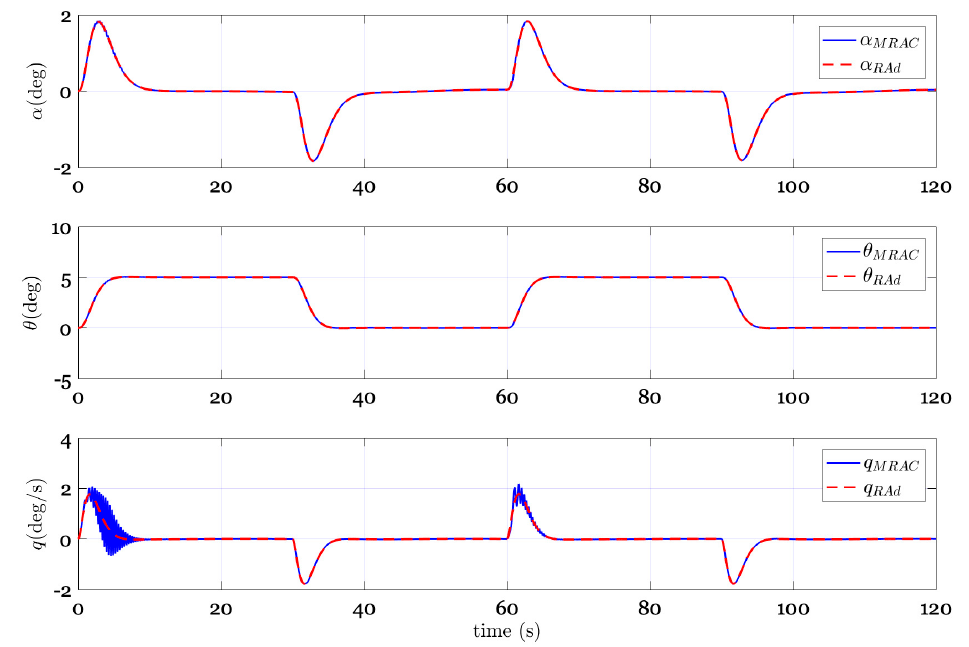
Figure 5. Tracking performance for MRAC and robust adaptive controller with 1 λ θ ρ ρ= = .